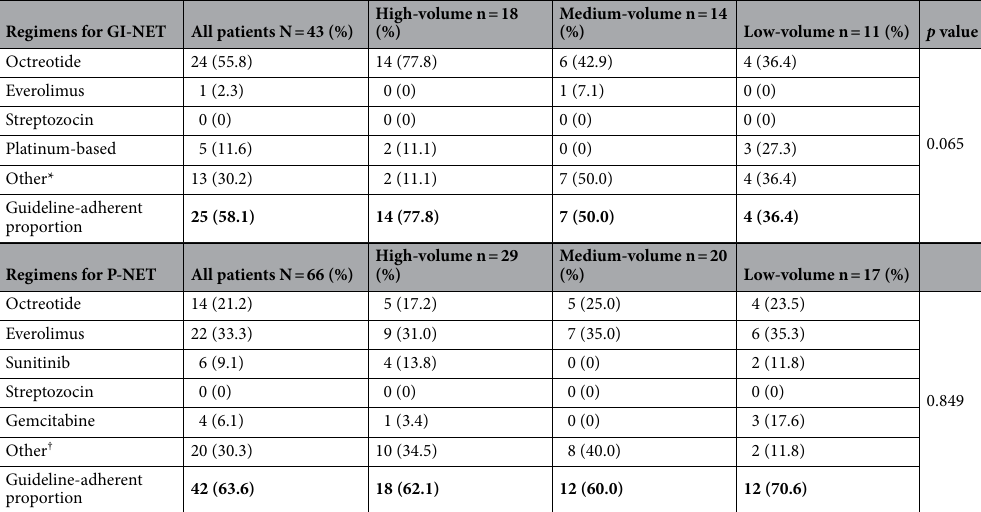
Regimens for GI-NET All patients N = 43 (%)